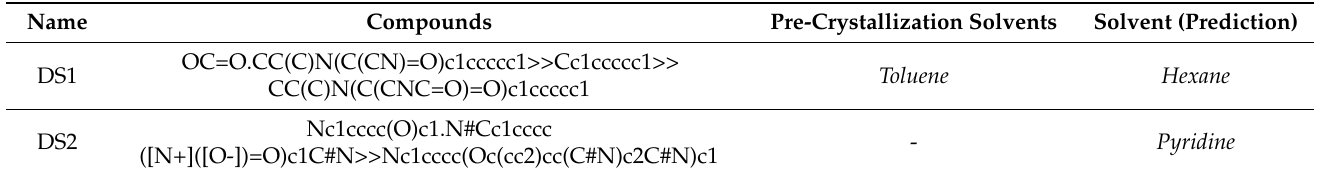
Table 1. Snippet from our dataset (compounds, solvents in the mixture before crystallization, and solvents used for the crystallization procedure are shown).